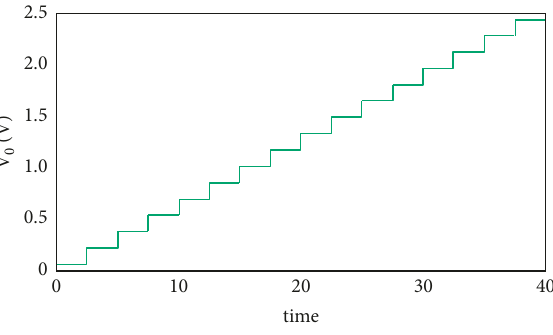
Figure 11: Simulation curve of D/A converter.